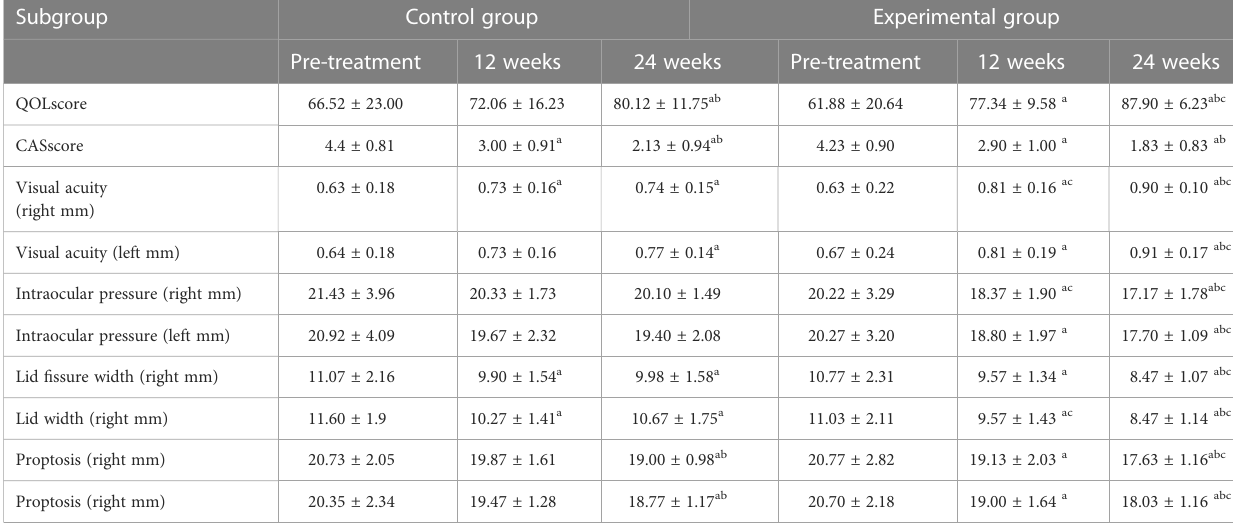
TABLE 3 Comparison of indicators between the two groups before the treatment, at 12 weeks, and at 24 weeks of